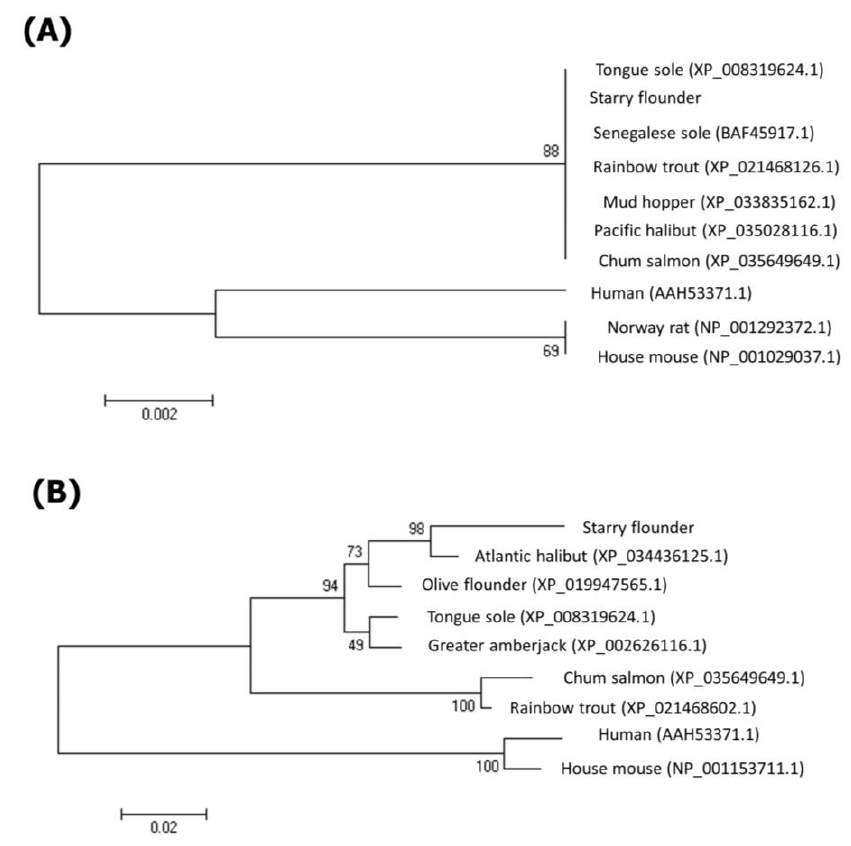
Figure 3. Phylogenetic analysis of deduced RPS27A ( A ) and S30FAU ( B ) amino acid sequences in fish. The phylogenetic tree was constructed using the neighbor-joining method within MEGA 4 software. Bootstrap sampling was performed with 1000 replicates.